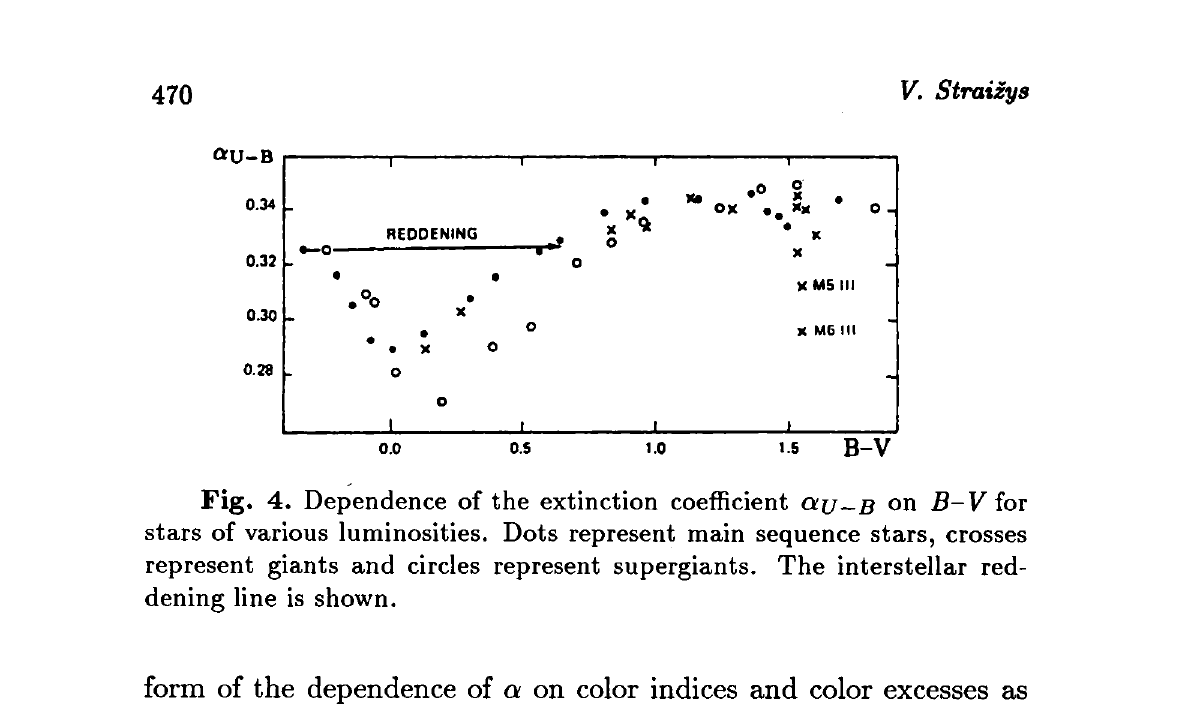
Fig. 4. Dependence of the extinction coefficient ajj—B on B-V for stars of various luminosities. Dots represent main sequence stars, crosses represent giants and circles represent supergiants. The interstellar red- dening line is